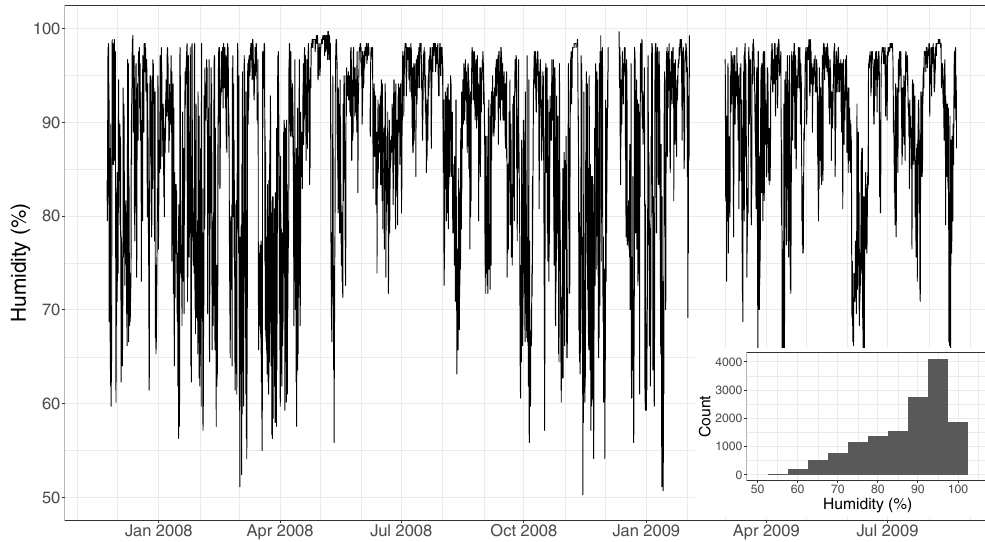
Figure 7. Measurements of relative humidity (%) at 3.5m height. A histogram of measurements is inset.